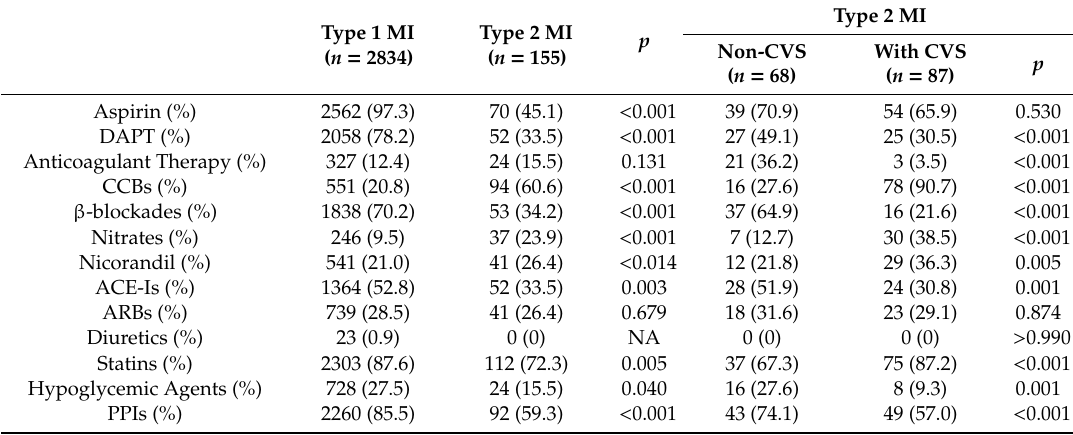
Table 2. Medication treatments at discharge.